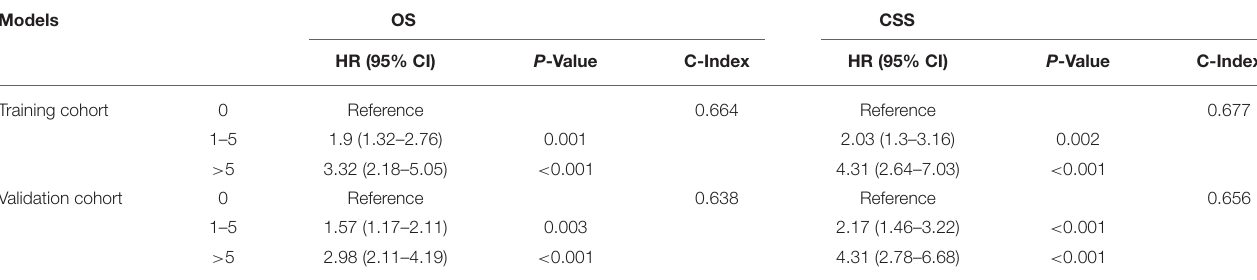
TABLE 4 | Comparison of survival predicting model based on training cohort ( N = 461) and validation cohort ( N = 365).